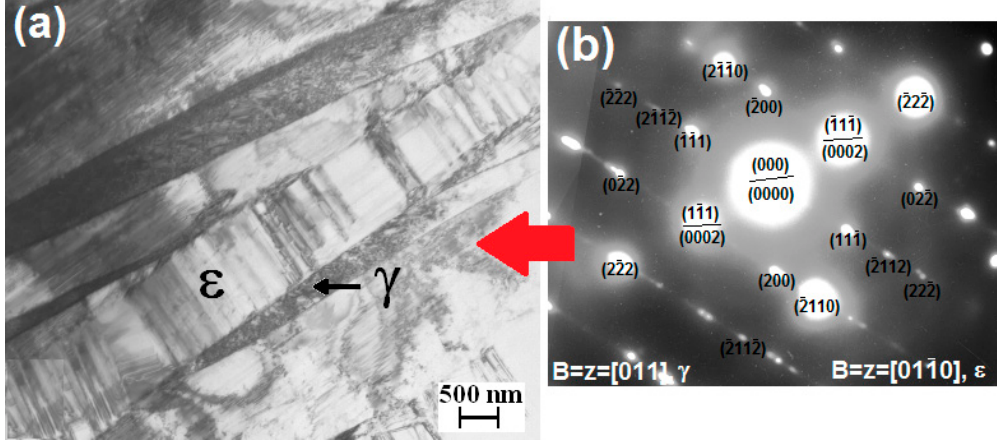
Figure 8. As-cast Co-20 wt. % Cr: ( a ) transmission electron microscope (TEM) micrograph showing the presence of FCC γ -Co phase between the ε -martensite plates; ( b ) corresponding electron diffraction pattern.